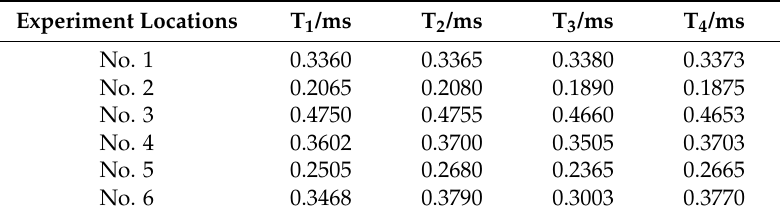
Table 2. Arrival time.